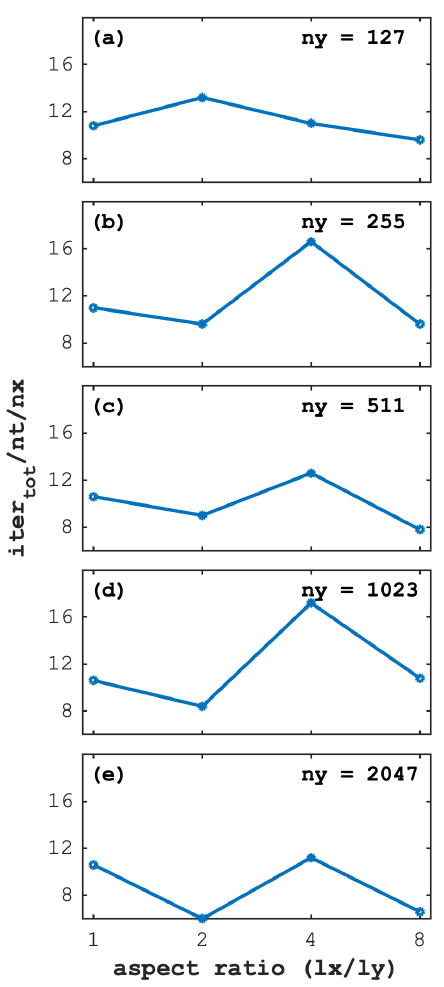
Figure 14. Iteration count scaled by the number of time steps ( n t ) and by the number of grid cells in the x direction ( n x ) as a function of increasing domain aspect ratios L x /L y for 5 different numerical resolutions (a) – (e) , respectively. The y -direction domain length is kept constant while the x -direction domain length and number of grid cells n x is increased up to 8 times. We use an identical 2D configuration as in the main study with the only difference being the nonlinear tolerance set here to tol nl = 10 − 6